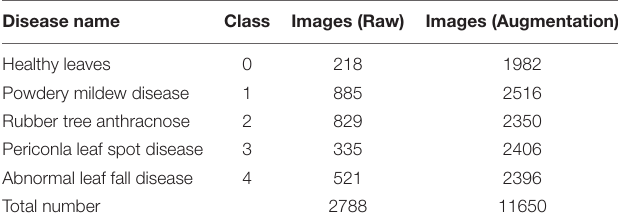
TABLE 2 | Detailed report of the constructed dataset before and after applying the augmentation process. Disease